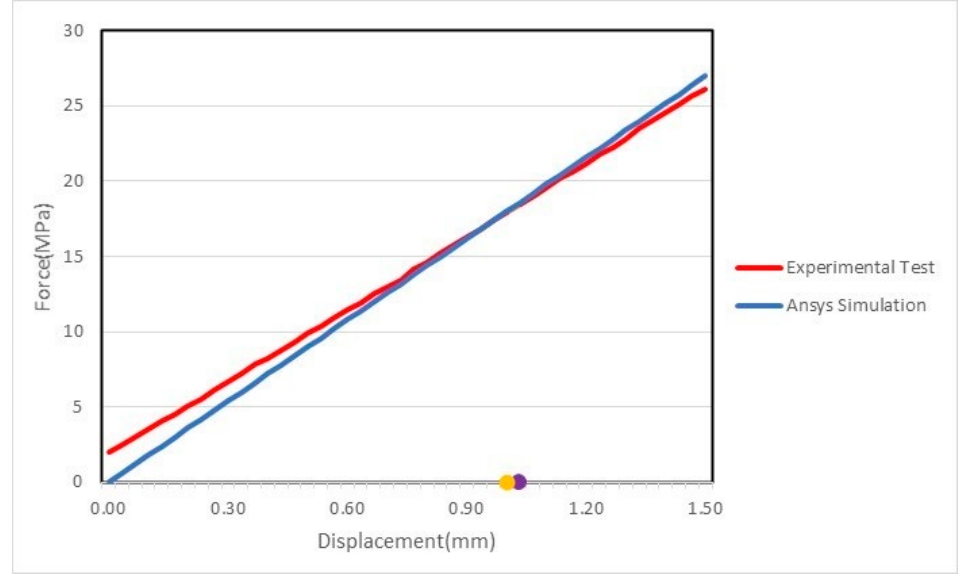
Figure 17. Experimental testing and ANSYS simulation